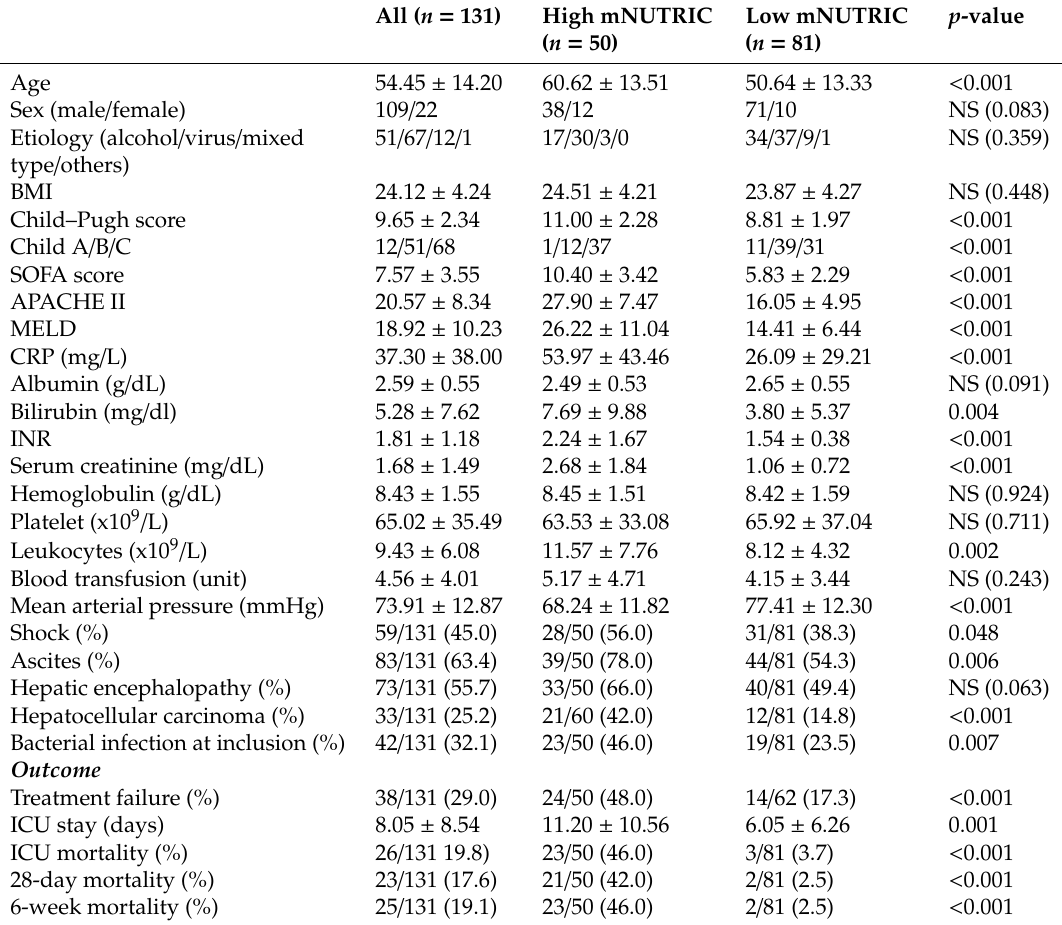
Table3. Patients’demographicdataandclinicalcharacteristicsgroupedaccordingtomodifiedNUTRICscore.